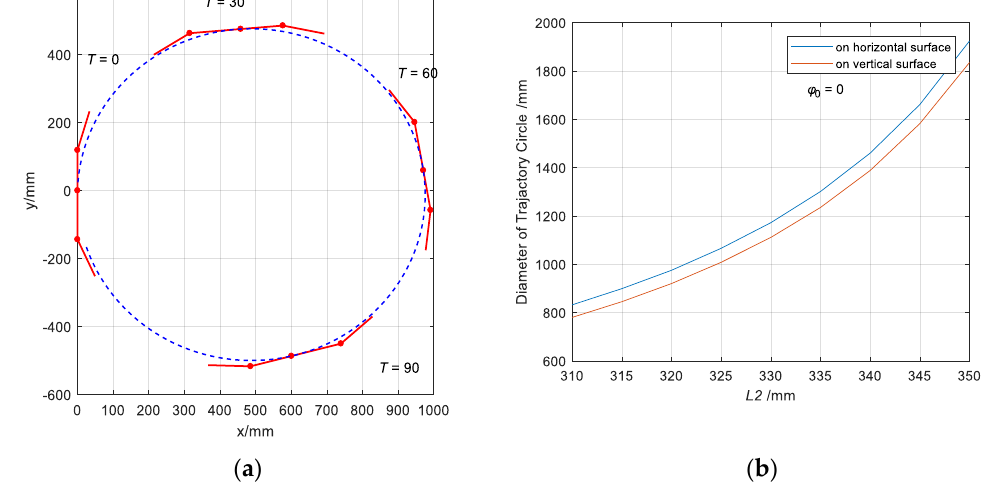
Figure 15. ( a ) Trajectory diagram of the climbing motion on a vertical surface in 120 cycles. At the initial phase ( L 2 = 400 mm, θ 2 = 20 ◦ ), the trajectory can be regarded as a circle. ( b ) The relationship between the diameter of the circle and the length of tendon L 2 in di ff erent motion patterns at the initial phase: ϕ 0 = 0.